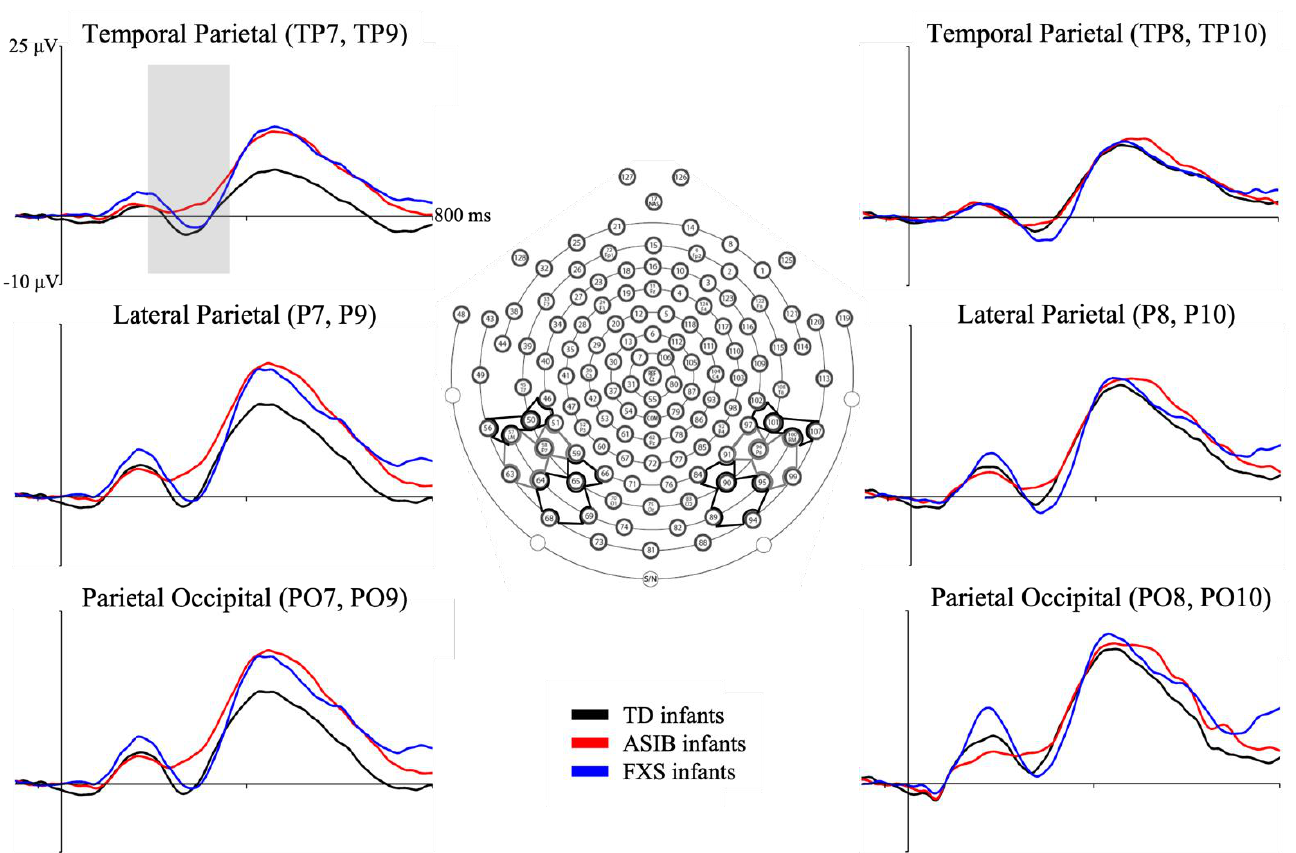
Figure 3. Grand average N290 responses by group at left and right parietal – occipital (PO; left: PO7 and PO9, right: PO8 and PO10), lateral – parietal (P; left: P7 and P9, right: P8 and P10), and temporal – parietal (TP; left: TP7 and TP9, right: TP8 and TP10) electrode clusters. Inferior posterior electrode clusters of interest are presented on the diagram of the electrode layout for the Electrical Geodesics, Inc. (EGI) Hydrocel Geodesic Sensor Net. This figure was first published in Guy, Richards, Tonnsen, and Roberts (2018) [4]. Note. TD = typical development, ASIB = infant sibling of child with autism, FXS = fragile X